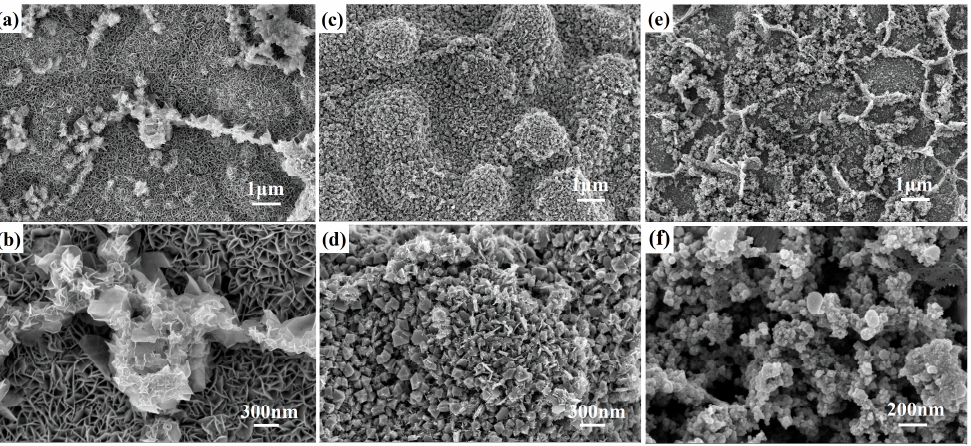
Figure 2. SEM images of e-NFF/NFF ( a , b ), e-NF-LDH/NFF ( c , d ) and e-NFP/NFF ( e , f